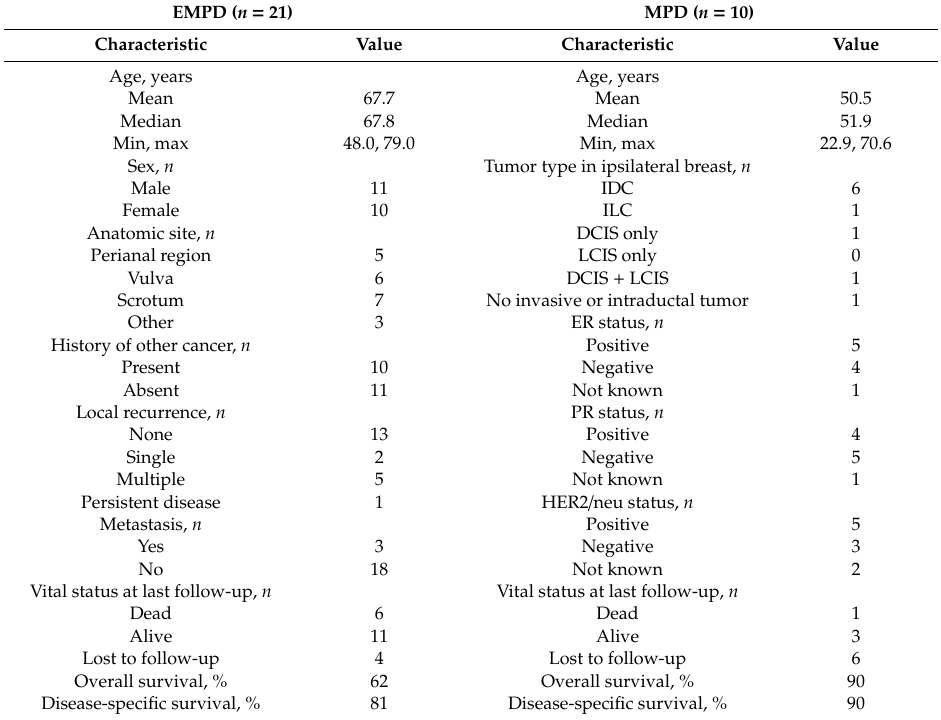
Table 1. Summary of demographic and clinical-pathologic findings in patients with extramammary Paget disease (EMPD) and mammary Paget disease